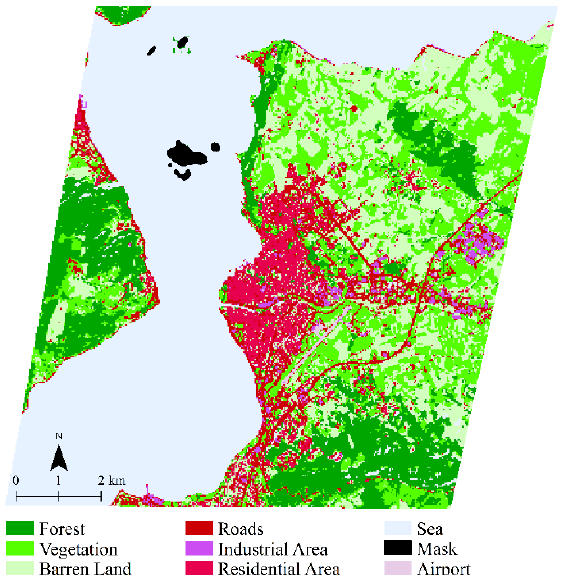
Figure 3. The LU/LC map that was produced by applying SVM to Landsat-9 satellite image.